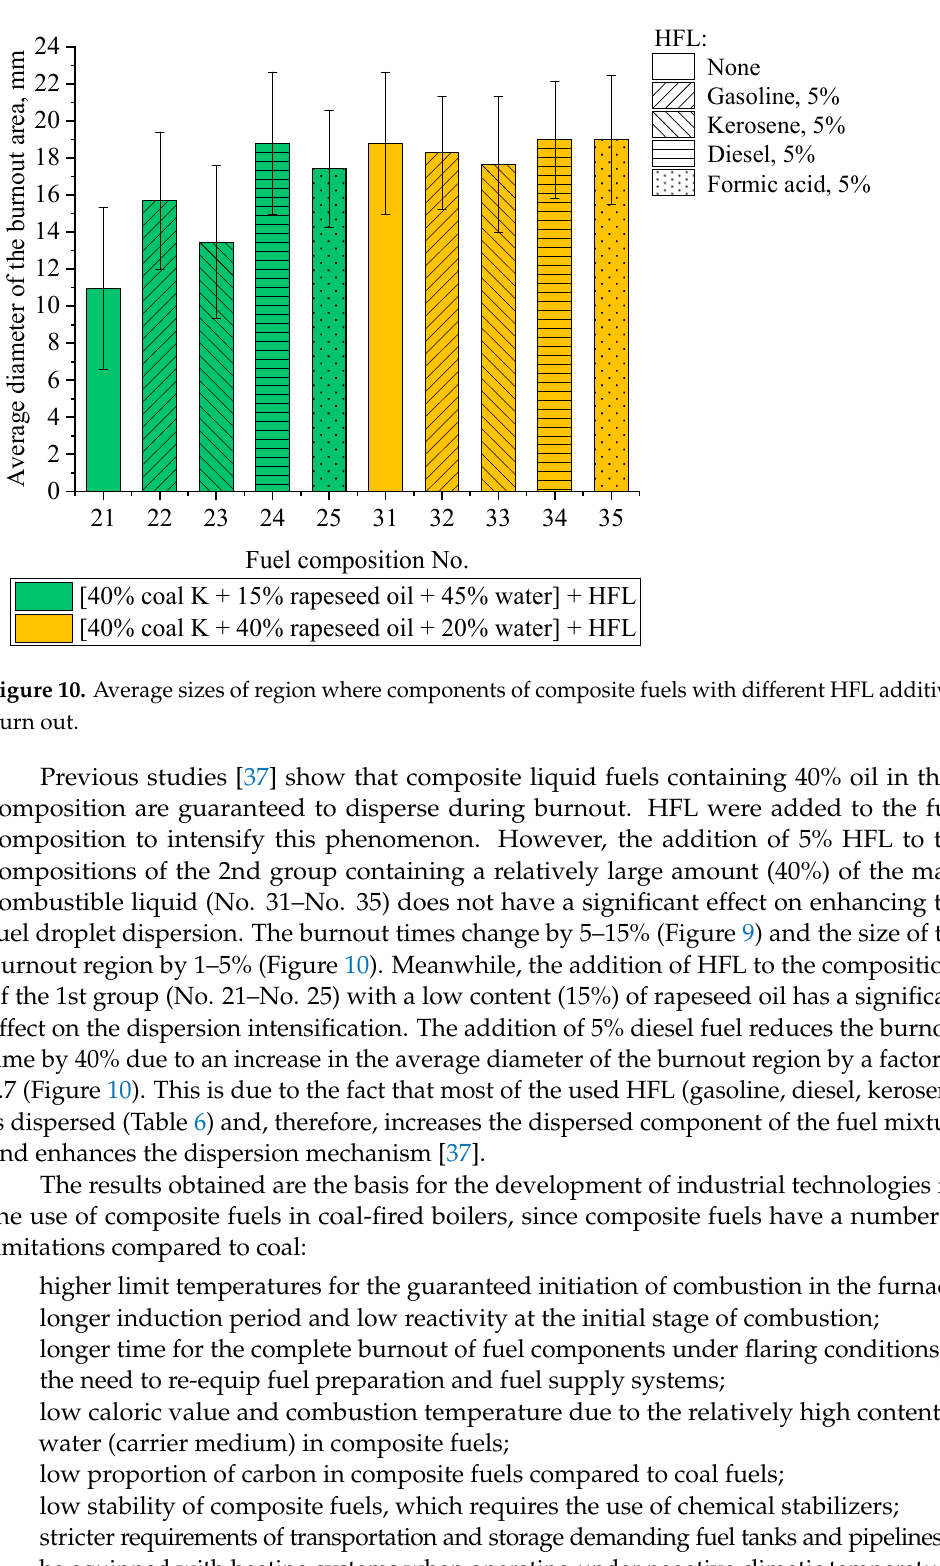
Figure 9. Burnout times of composite fuel droplets with different HFL additives.